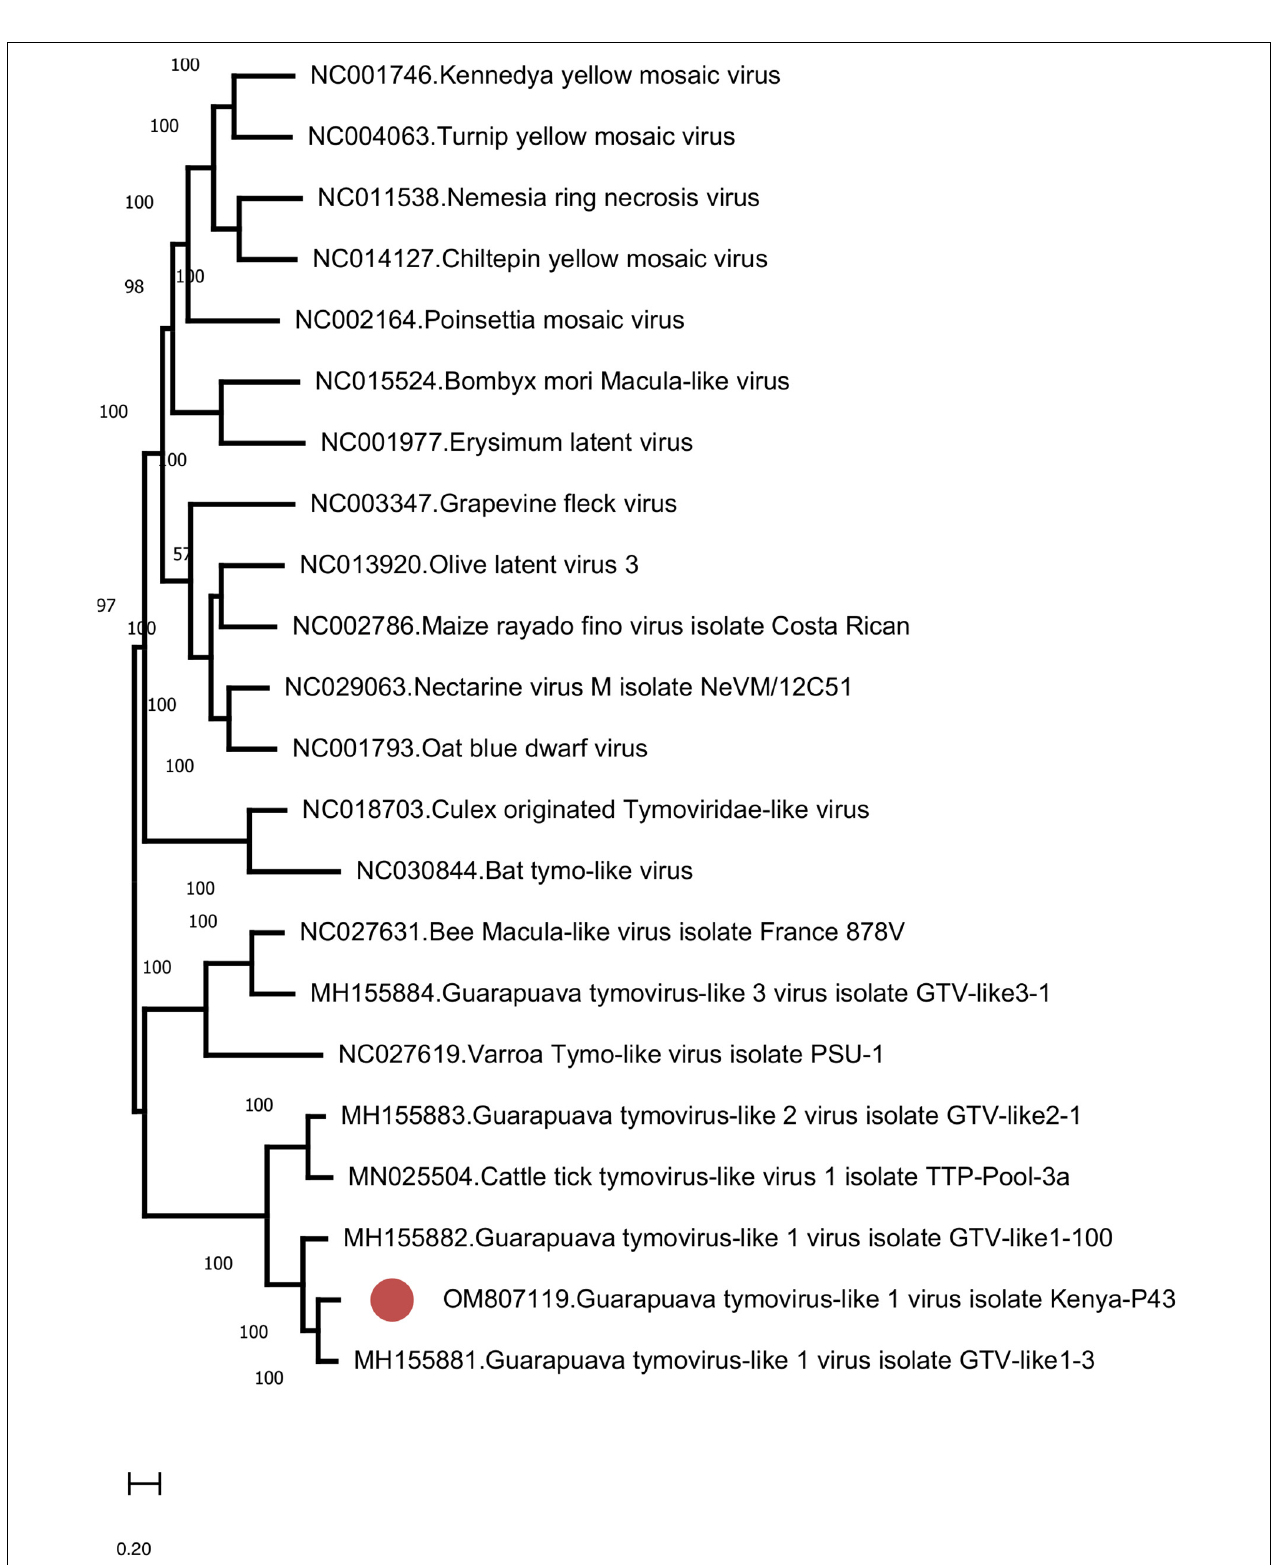
FIGURE 5 | The maximum likelihood analysis of the Guarapuava tymovirus-like virus ORF sequences (5,898 nucleotides). The tree is constructed using the general time reversible (GTR) model, gamma distributed with invariant sites (G + I) model for 500 replications. Guarapuava tymovirus-like 1 virus isolate Kenya-P43 characterized in this study is marked (GenBank accession: OM807119). Bootstrap values greater than 50 are displayed.